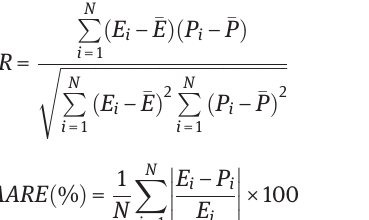
where E is the experimental flow stress and P is the predicted flow stress obtained from the developed con- stitutive equation considering strain compensation. (cid:2) P are the mean values of E and P respectively. N is the total number of data used in this study.